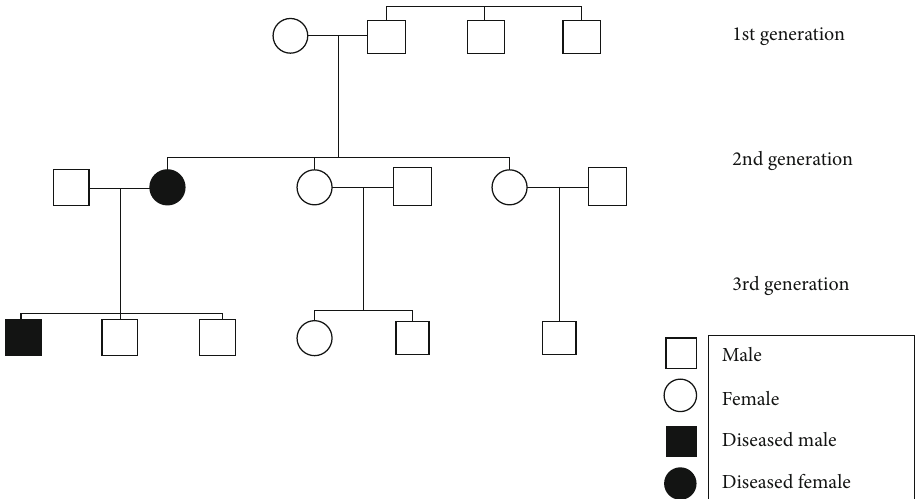
Figure 3: Pedigree of the patient showing hereditary pattern of trichoepitheliomas.